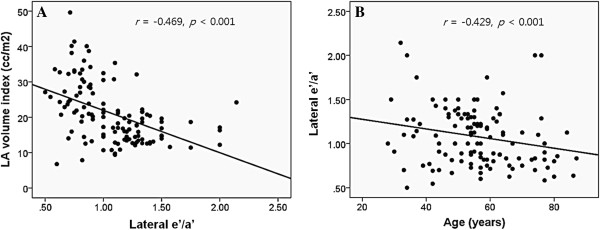
Scatter plots showing the associations of lateral e’/a’ with left atrial volume index (A) and age (B). LA, left atrium. r, correlation coefficient.